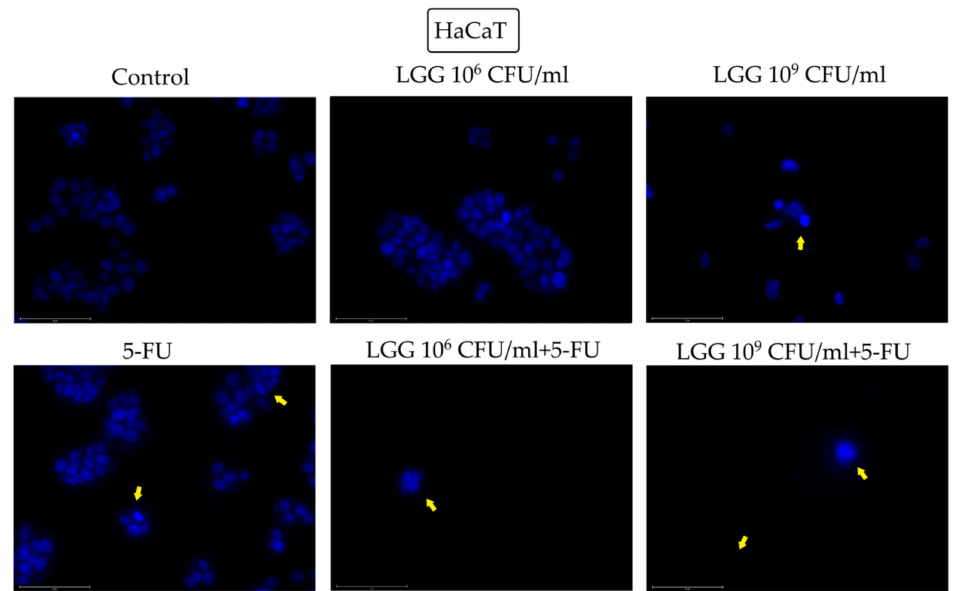
Figure 2. Nuclear morphological changes in HaCaT cells observed following 48 h treatment with LGG 10 6 and 10 9 CFU/mL, alone or in association with 10 µ M 5-FU. The yellow arrows represent signs of apoptosis (nuclear shrinkage, fragmentation, condensation, and cellular membrane disruption). The scale bar is 75 µ m.